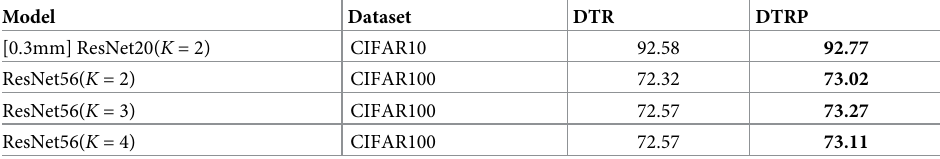
Table 4. Top-1 accuracy (%) for models with different K on CIFAR10 and CIFAR100.